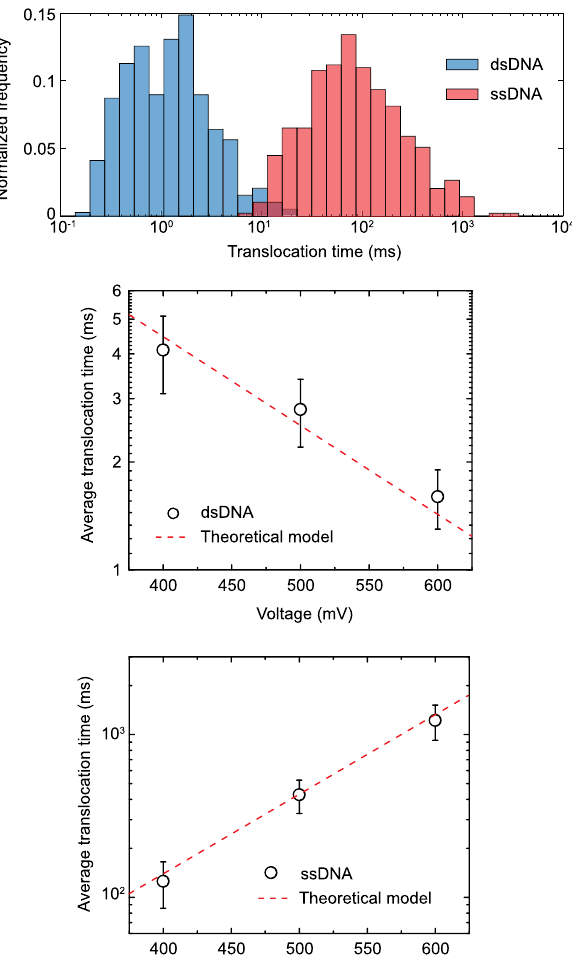
Fig. 6 Comparison between dsDNA and ssDNA experimental translocation times. a Normalized histogram of translocation times for 22 nt ssDNA ( n = 390 events) and 22 bp dsDNA ( n = 492 events). ssDNA translocates much slower than dsDNA under the effect of electric fi eld leakage (for a nanopore with a diameter of 10 nm, half cone angle ~7 ± 2° coated with 3 nm Al 2 O 3 fi lm under an applied voltage of 500 mV). These signature electrical signals allow discrimination (>97%) between ssDNA and dsDNA duplex translocation events (see Supplementary Fig. 6). b Average dsDNA translocation time dependence as a function of the applied voltage ( n = 3). The line represents the fi t of the data to the model ( τ ¼ τ 0 e (cid:2) W = k B T ; where W is given by Eq. (3) with τ 0 = 45 ms for a dsDNA